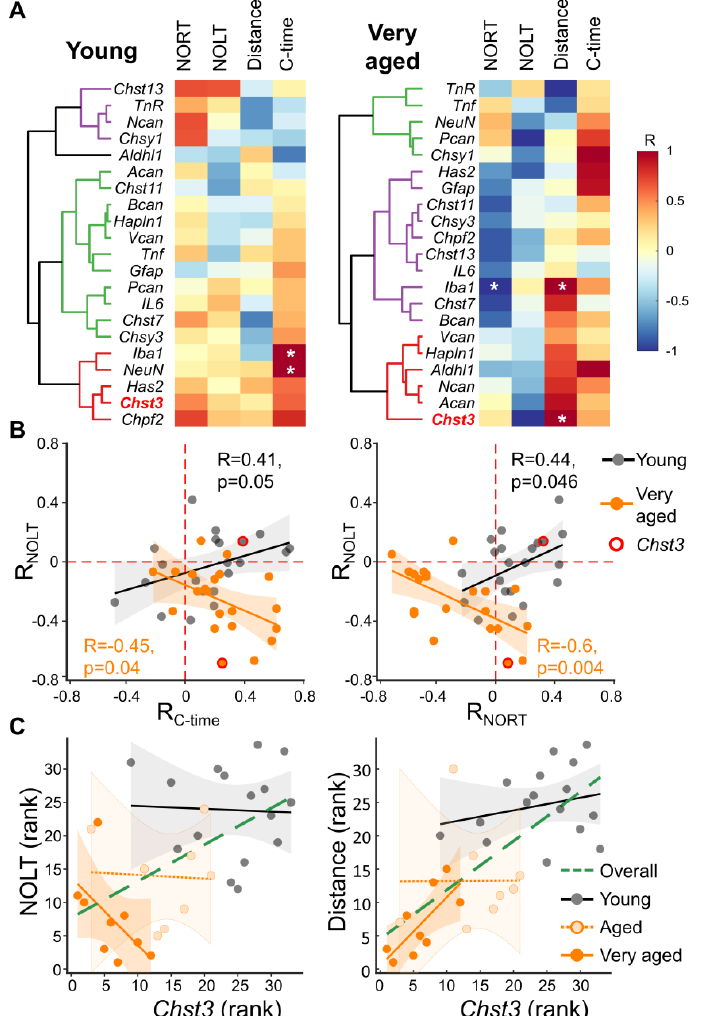
Figure 4. Spearman’s correlation between gene expression and behavioral characteristics of mice. ( A ) For each young and very aged animal, the readouts for the open-field test including the distance traveled and the time spent in the central zone of the arena (C-time) together with the performance of mice in NOLT and NORT tests were correlated with gene expression for each age subgroup. ( B ) Different gene/behavior bi-correlation patterns in different age cohorts were estimated. Herein, each point represents one gene in the coordinates of its correlation with the corresponding behavioral parameters: the left panel- NOLT and C-time; the right panel- NOLT and NORT. The average and confidence intervals of the linear regressions for the young (gray) and very aged (orange) groups are shown as lines and shaded areas, respectively. The correlation values for Chst3 are highlighted with a red circle. ( C ) The correlation of Chst3 mRNA expression with behavioral characteristics was measured. The correlations between Chst3 mRNA levels and NOLT (left panel) or distance traveled (right panel) were calculated for young, old, and very aged individuals separately: grey, light, and deep orange, respectively. The overall correlation, confounded by age, is indicated by the green dashed line. Significant correlations for the left panel were: R = − 0.68, p < 0.05 for very aged and R = 0.54, p < 0.001 for overall regressions. Significant correlations for the right panel were: R = 0.75, * p < 0.05 for very aged and R = 0.72, p < 0.001 for overall